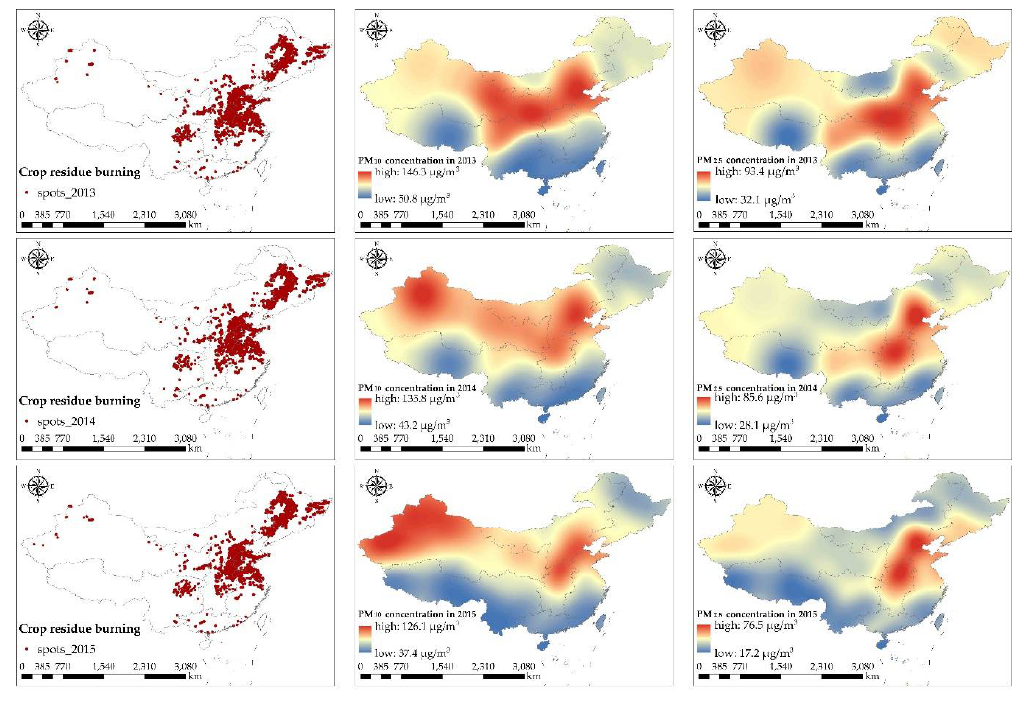
Figure 4. The spatial distribution of crop residue burning and particulate matter (PM) concentrations in the different regions of China. The left column shows the spatial distribution of crop residue burning spots in mainland China. The middle and right columns show the spatial distribution of PM 10 concentration and PM 2.5 concentration, respectively, in China by interpolating.